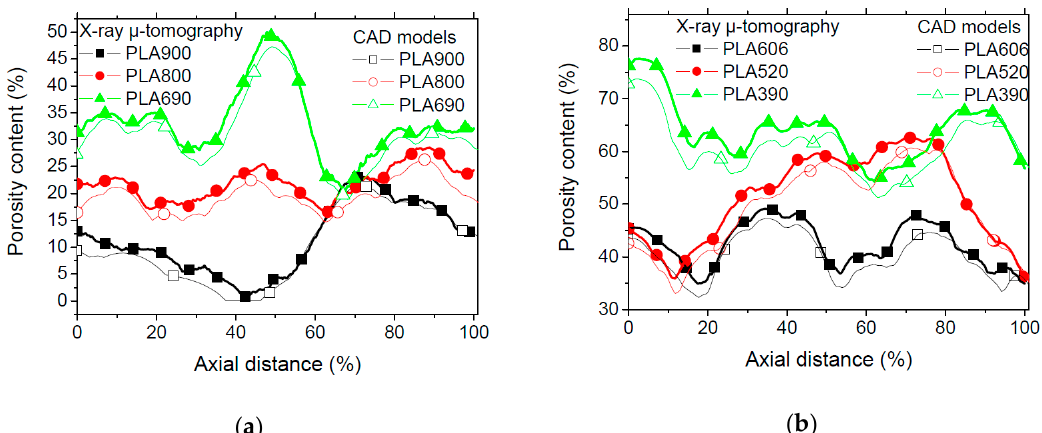
Figure 6. Comparison between porosity content profiles of Computer Aided Design (CAD) and X-ray micro-tomography along the building direction for 3D printed PLA cellular materials exhibiting ( a ) low (<40%) and ( b ) large (>30%) porosity contents.